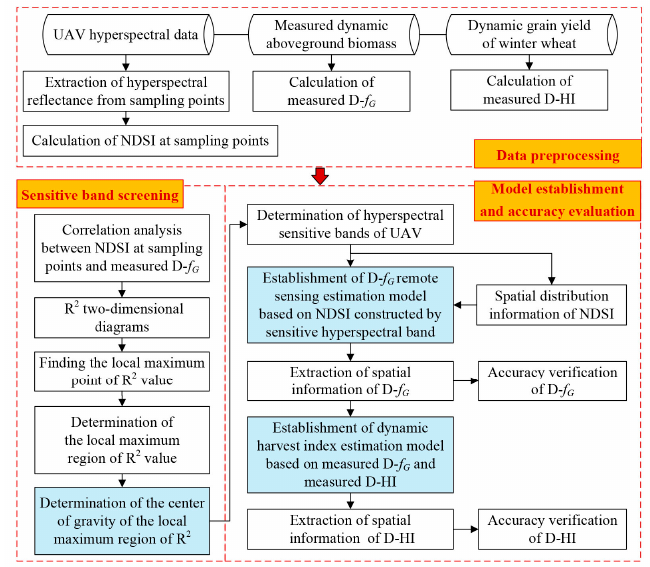
Figure 3. Overview of the methods applied in this research.